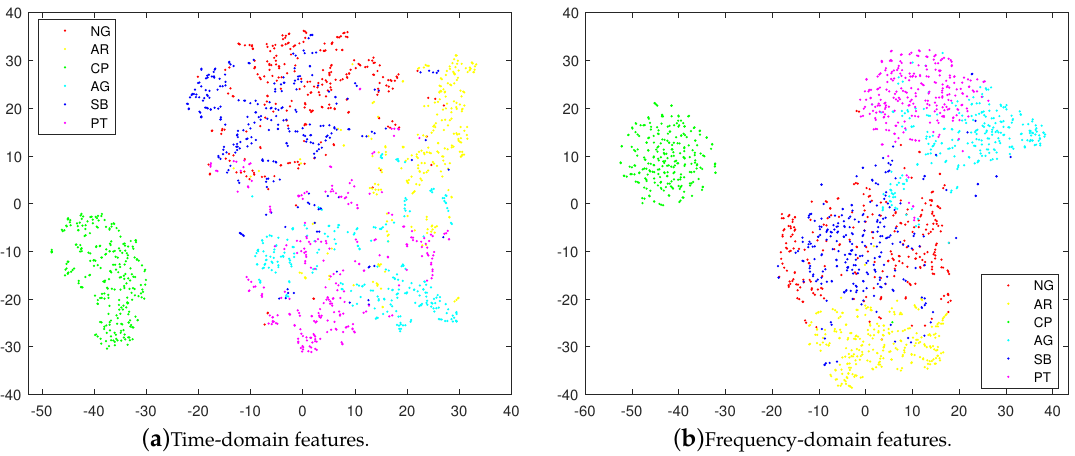
Figure 5. The t-SNE visualisation of the feature representations of our data